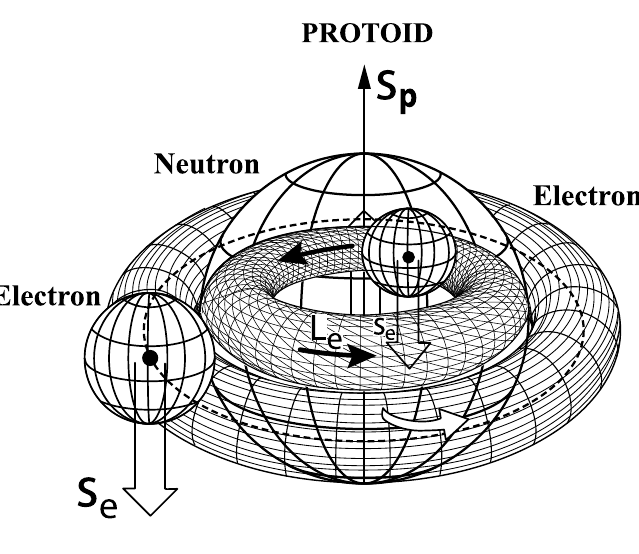
Figure 13: A conceptual rendering of the protoid as weakly bounded electron and neutron in singlet contact coupling, resulting in a negatively charged hadron with spin S = 0 with intriguing